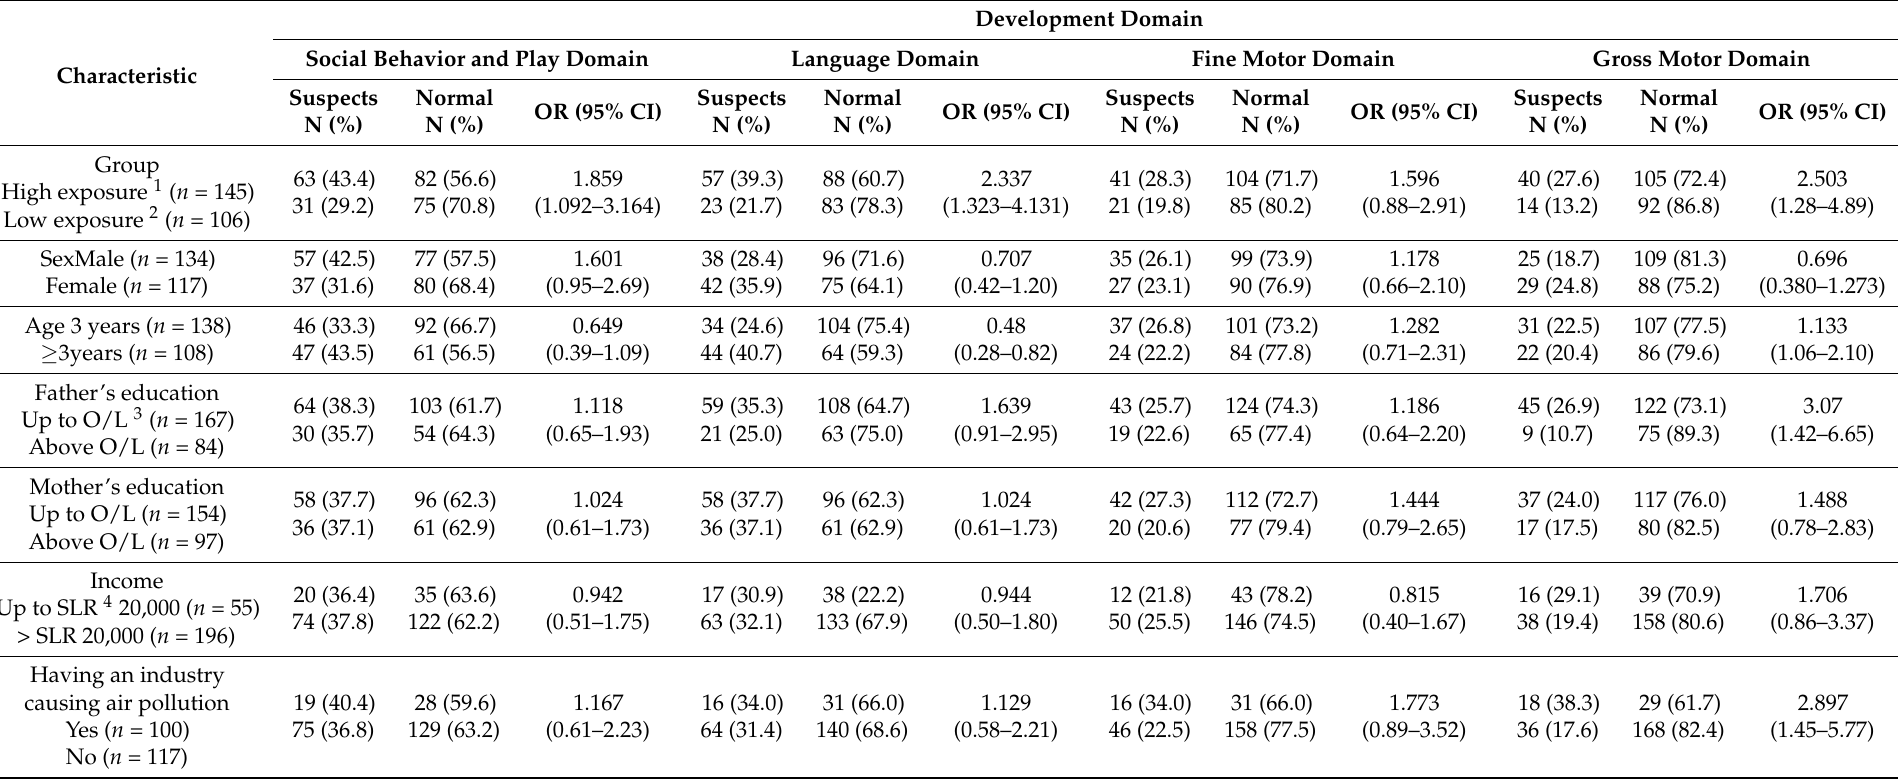
Table 1. Development assessment by selected socio-demographic